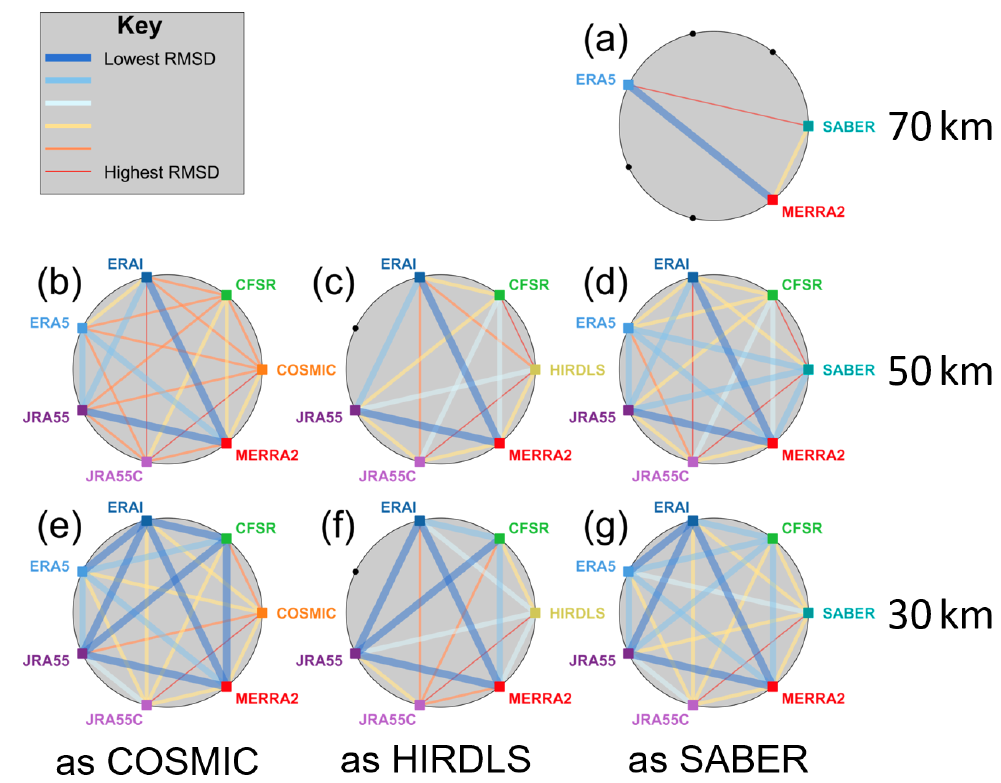
Figure 16. Pairwise RMSD between each dataset at three height levels. Black dots and coloured squares around each circle indicate nodes representing each model or observational dataset, with coloured squares indicating comparisons performed and black dots indicating unavail- able comparisons due to spatial and temporal coverage constrains. Coloured lines joining nodes indicate pairwise RMSDs between the data sources associated with those nodes, described by the key at the top